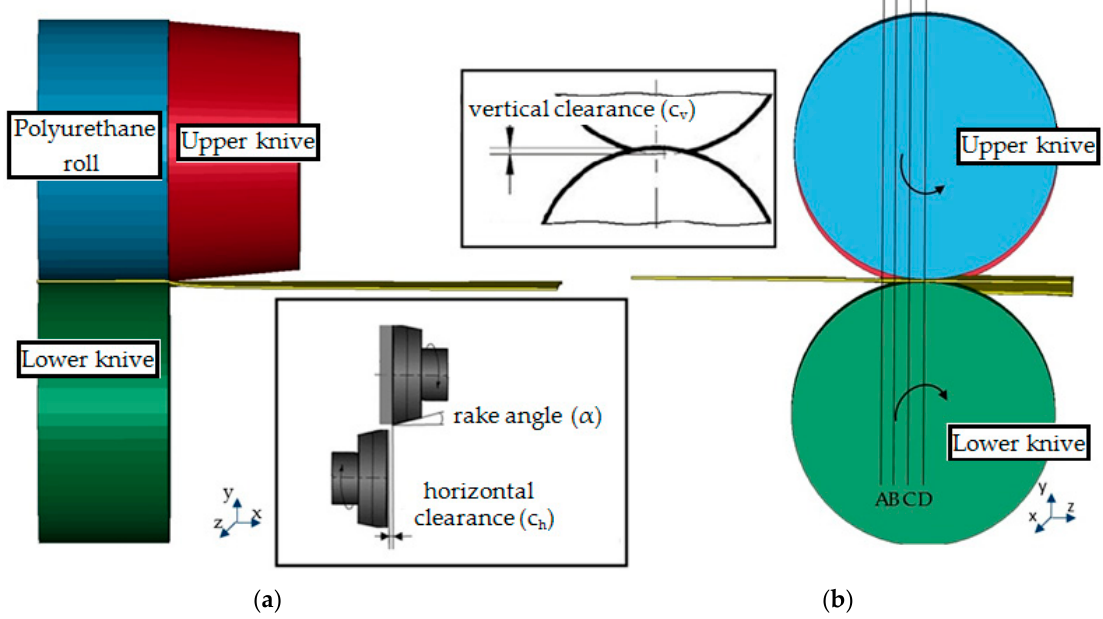
Figure 1. Illustration of the shear-slitting process with specifying parameters: ( a ) Front view; ( b ) Side view.